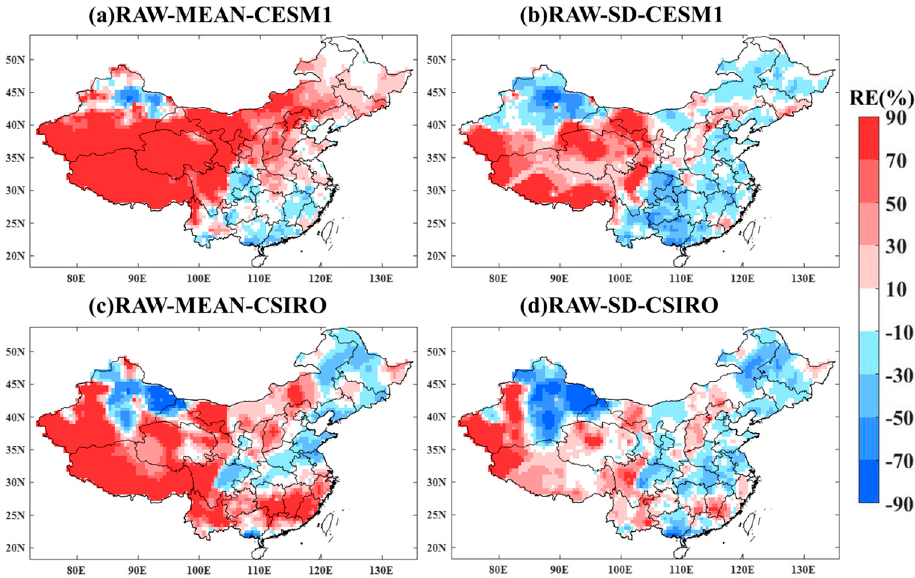
Figure 2. The relative error (RE) of the mean (MEAN) and standard deviation (SD) for July precipitation for two climate model ensembles (CESM1; CSIRO) with raw (RAW) simulated data for the reference period (1971–2000). ( a ) The RE of the mean July precipitation for CESM1 with raw data; ( b ) The RE of the SD of July precipitation for CESM1 with raw data; ( c ) The RE of the mean July precipitation for CSIRO with raw data; ( d ) The RE of the SD of July precipitation for CSIRO with raw data.